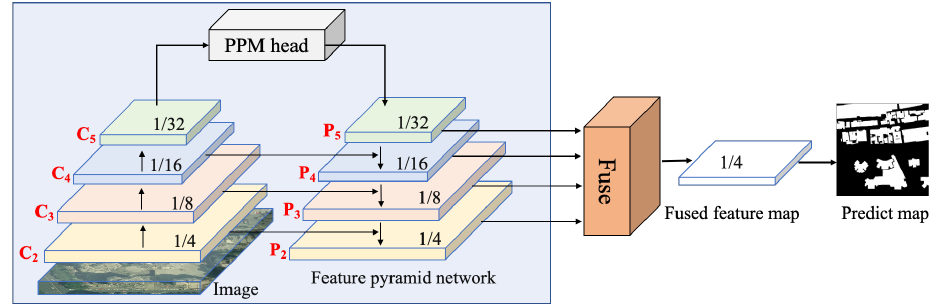
Figure 8. UPerNet